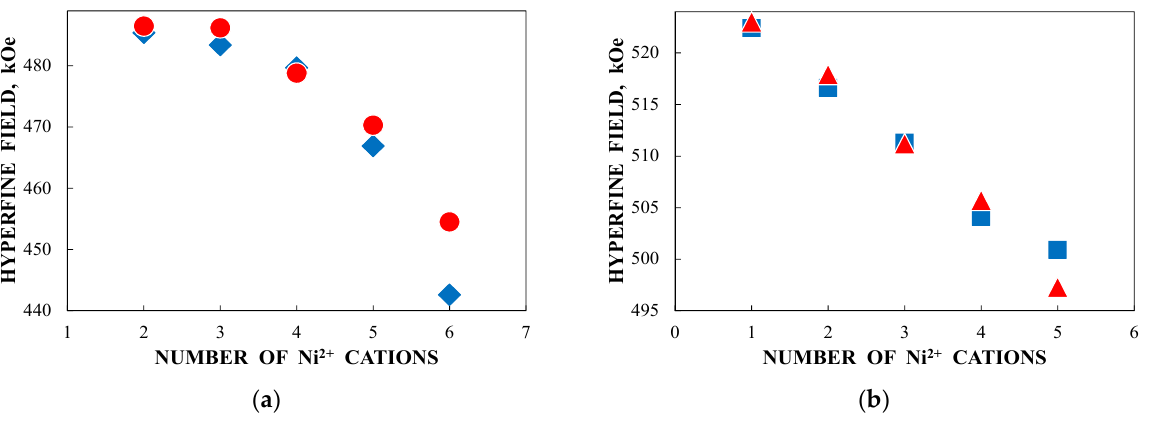
Figure 54. Dependencies of the hyperfine field at the 57 Fe nuclei vs. number of Ni 2+ cation in the Fe 2+ local microenvironments in both tetrahedral ( a ) and octahedral ( b ) sites of NiFe 2 O 4 nanoparticles in NA ( ♦ ) and NB ( • ) samples. Adapted from Ref. [79] with permission from Elsevier: Materials